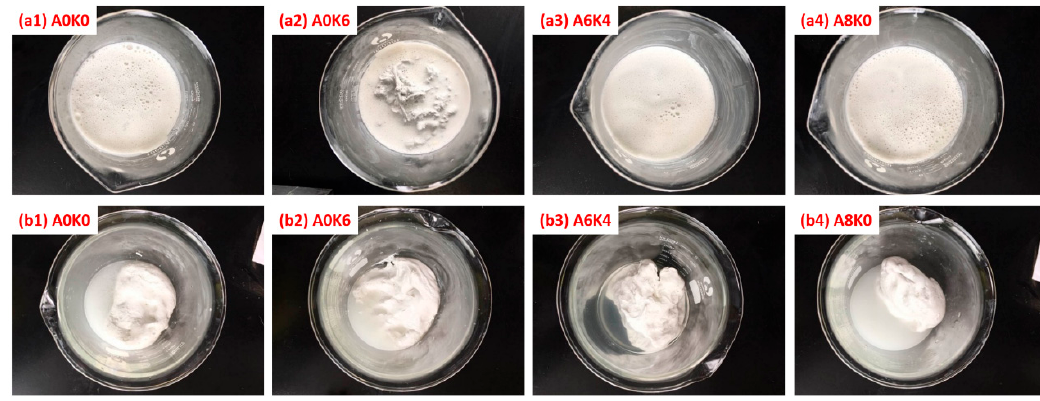
Figure 6. Preparation process of the master batches with pure and modified silica.